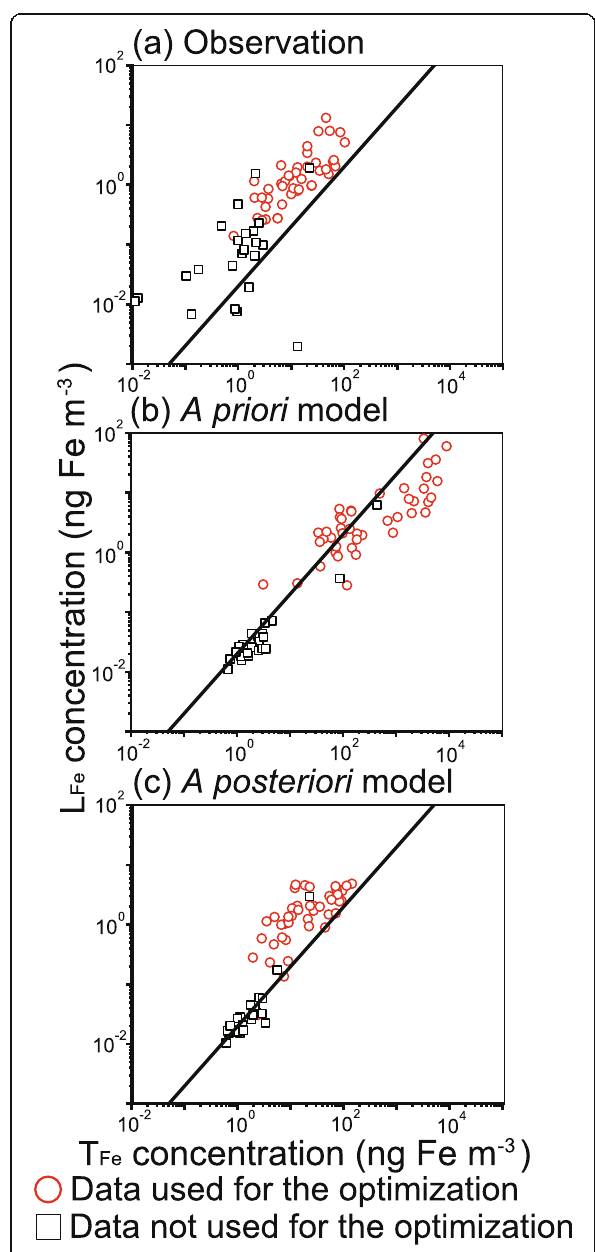
Fig. 3 Relationship between T Fe and L Fe concentrations (ng Fe m – 3 ) in aerosols for a observations, b a priori model estimates, and c a posteriori model estimates over the 70°E – 150°E and 10°S – 70°S sector of the SH. The solid black line shows a linear trend with a constant Fe solubility of